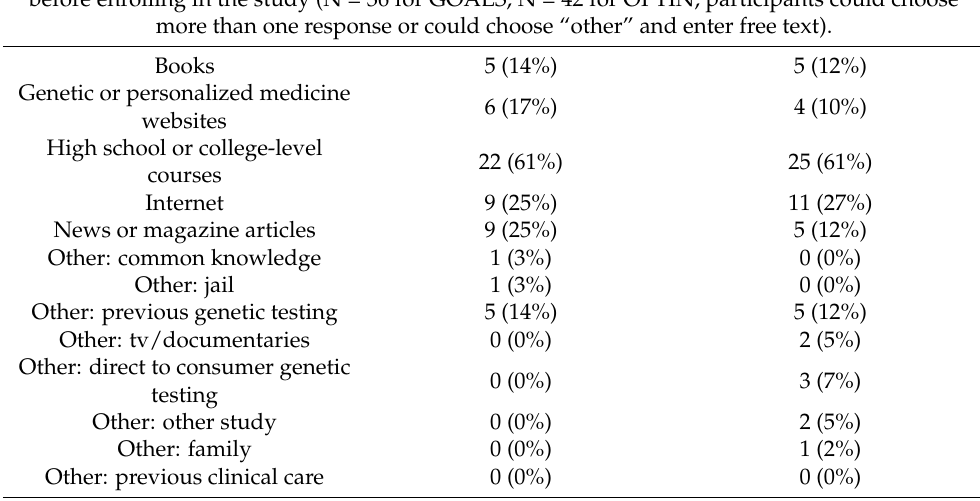
Table 2. Cont. GOALS (N = 125) OPTIN (N = 119) “Through which sources [have you been exposed to genetics before enrolling in the